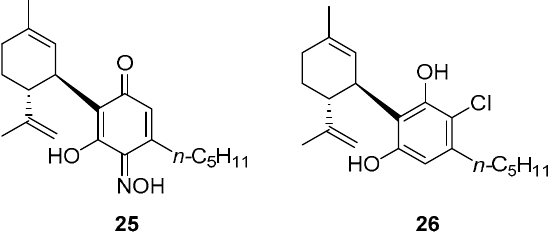
Figure 5. Structure of hydroxyiminodienone ( 25 ) and chlororesorcinol ( 26 ), resulting from treatment of CBD ( 7 ) with the Takehira reagent.